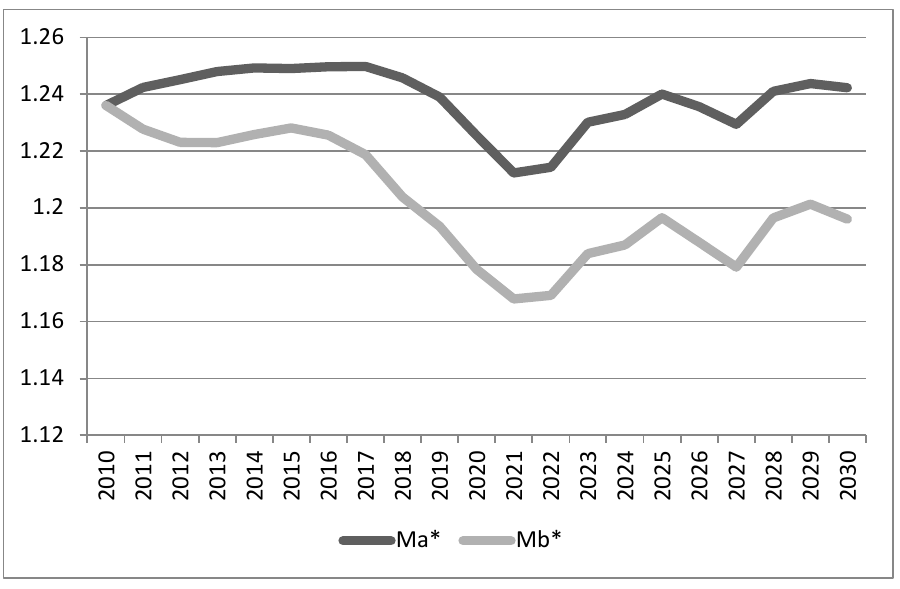
FIGURE 10: Plotting the reaction function from 2010 to 2030, using 2010 as a base year and applying the data as per the base case scenario in the final report of the IRP 2010-